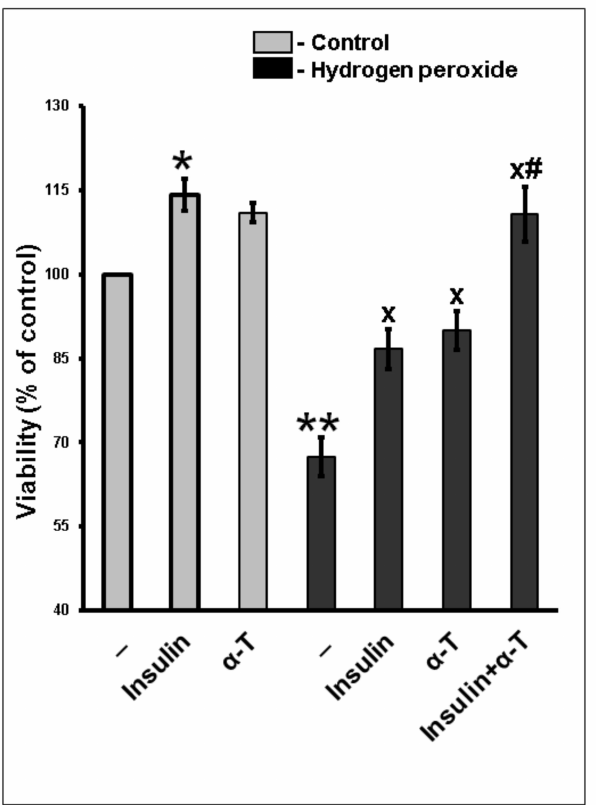
Figure 1. The additive protective effect of insulin and α -tocopherol ( α -T) on the viability of rat brain cortical neurons exposed to hydrogen peroxide. The data of 5–7 experiments are presented as the means ± SEM. The neuronal viability was determined using 3-(4,5-dimethy-2-thiazolyl)-2,5-diphenyl- 2 H -tetrazolium bromide (MTT) method. Abbreviations used: α -tocopherol ( α -T). Cortical neurons were pre-incubated for 1 h with 1 µ M insulin or for 18 h with 50 µ M α -T or with both compounds or without them. Then the neurons were exposed to 100 µ M hydrogen peroxide for 6 h. The differences are significant according to one-way analysis of variance (ANOVA) followed by Tukey’s test for multiple comparisons as compared: *—to control, x—to the effect of hydrogen peroxide alone, #—to the effect of either insulin, or α -T alone, * p < 0.05, ** p < 0.01. in all other cases p <